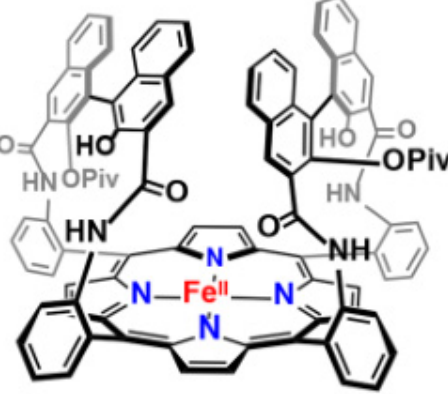
Figure 4. “Single-coronet” model system designed by Naruta and co-workers. Reprinted with permission from Ref. [15]. Copyright 2018, American Chemical Society.